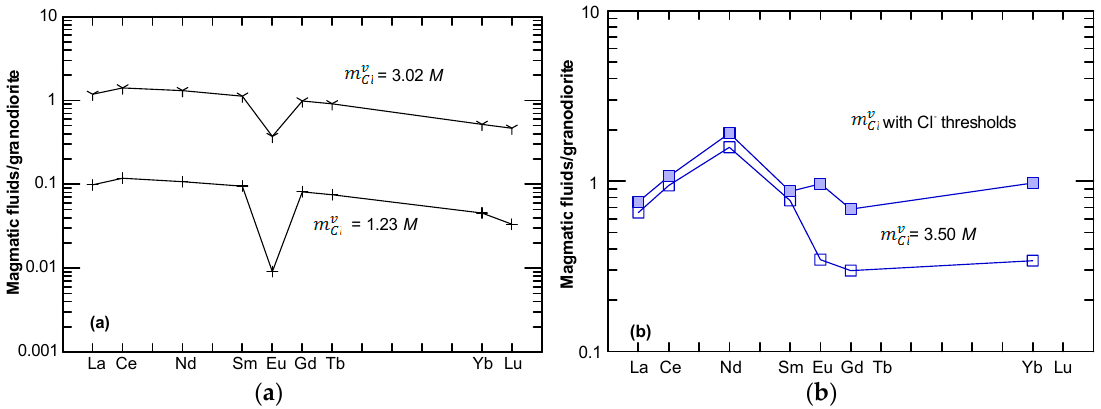
Figure 4. Lake George granodiorite-normalized REE distribution patterns of magmatic fluids with a Cl molality of m v equal to 1.23 to M and 3.02 M ( a ), and the Bakircay granodiorite-normalized REE distribution patterns of magmatic fluids with m v values equal to 3.50 M and the threshold value ( b ). The normalization values are taken from Table 4.